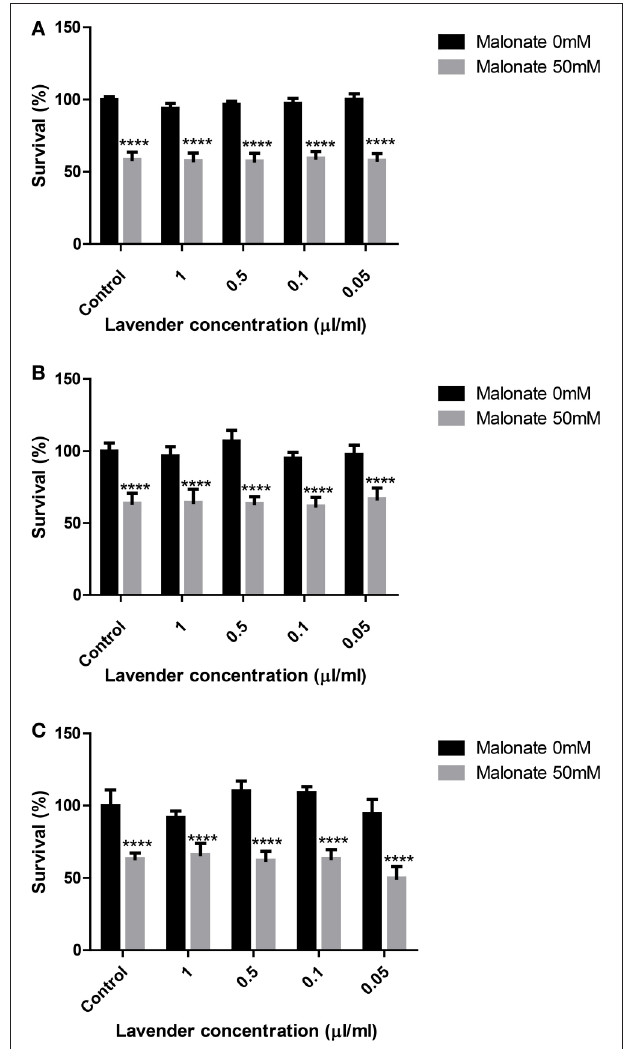
FIGURE 4 | Effect of lavender essential oil on malonate induced toxicity on SH-SY5Y cells at 0 (A) , 2 (B) , and 24h (C) . **** p < 0.0001 vs. 0mM malonate in the respective lavender